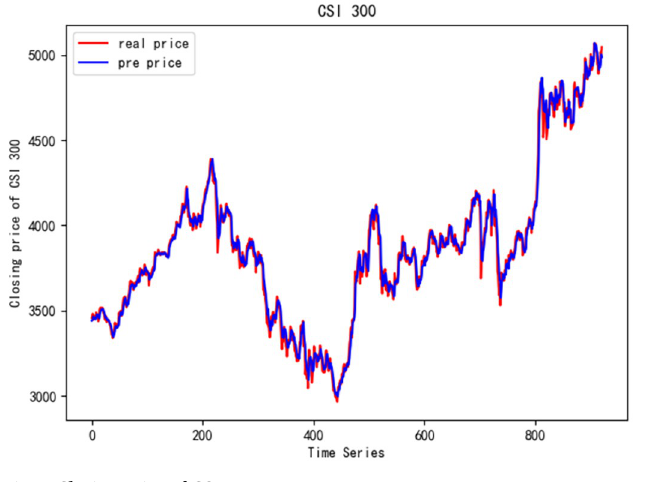
Fig 7. Closing price of CSI